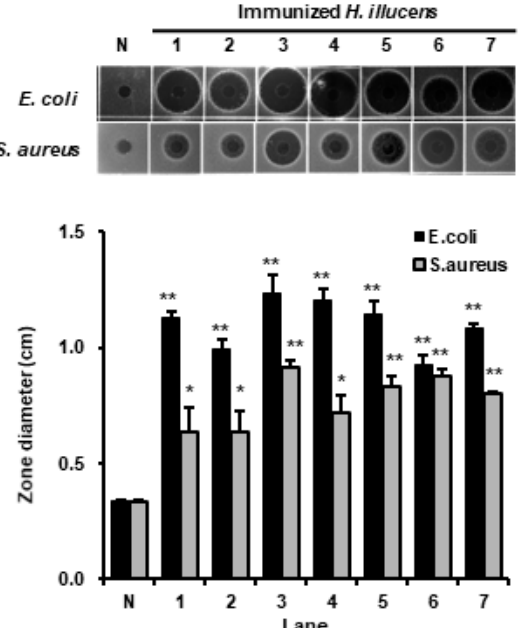
Figure 1. Comparison of antimicrobial activities to E. coli and S. aureus in the hemolymph of HIL immunized with E. faecalis , S. marcescens , L. acidophilus , L. brevis , L. casei , L. fermentum , or L. delbrueckii . N indicates non-immunized hemolymph of H. illucens. Lane 1, hemolymph of S. marsescen- immunized HIL; lane 2, hemolymph of E. faecalis- immunized HIL; lane 3, hemolymph of L. casei- immunized HIL; lane 4, hemolymph of L. acidophilus- immunized HIL; lane 5, hemolymph of L. brevis- immunized HIL; lane 6, hemolymph of L. fermentum- immunized HIL; lane 7, hemolymph of L. delbrueckii- immunized HIL. The values of column graphs are presented as the mean ± S.D. * and ** indicate p < 0.05 and p < 0.01 vs. normal control (N), respectively.